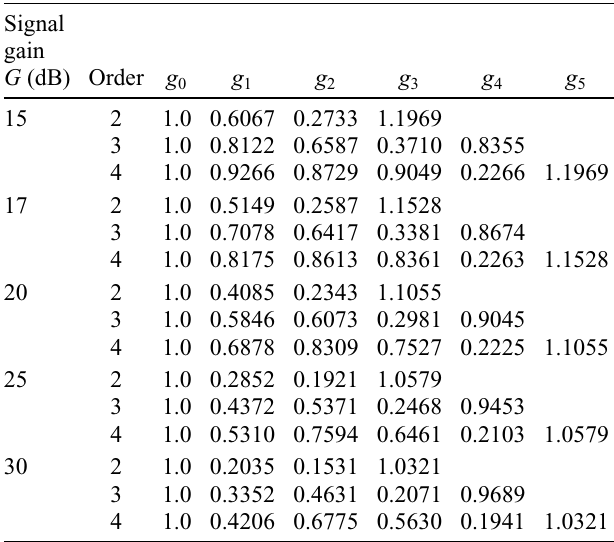
TABLE II. Butterworth coefficients calculated according to Appendix E for several amplifier gains, and for two-, three-, and four-section networks, using the power loss function in Eq.